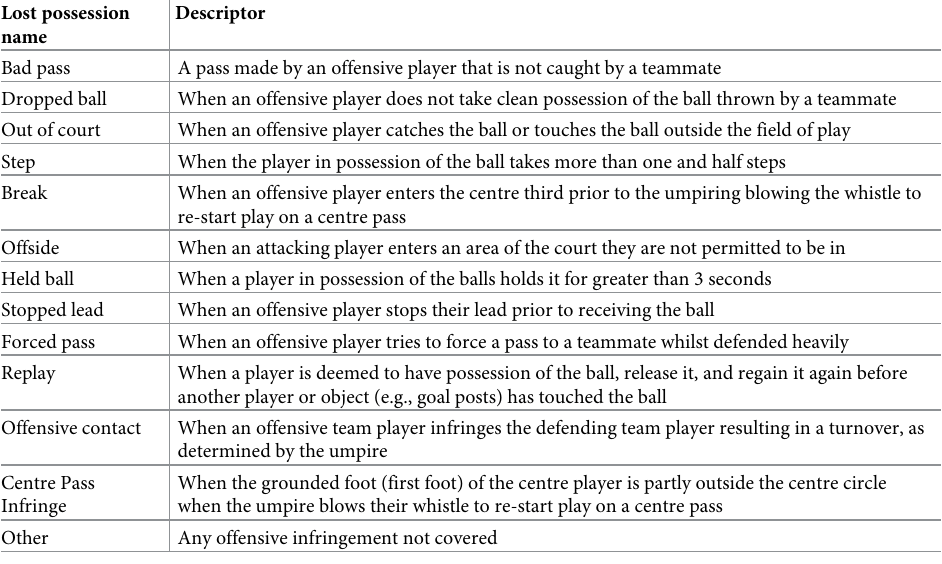
Table 3. List of definitions for how the offensive team may lose possession of the ball.